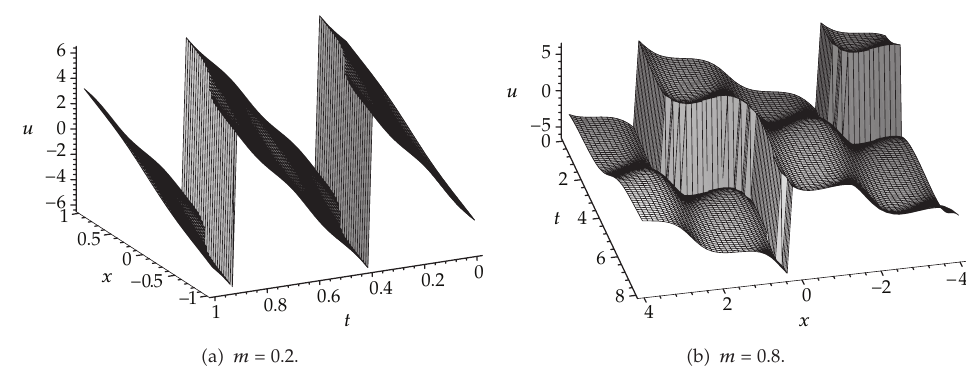
Figure 1: Two special cases of interaction solution u 1